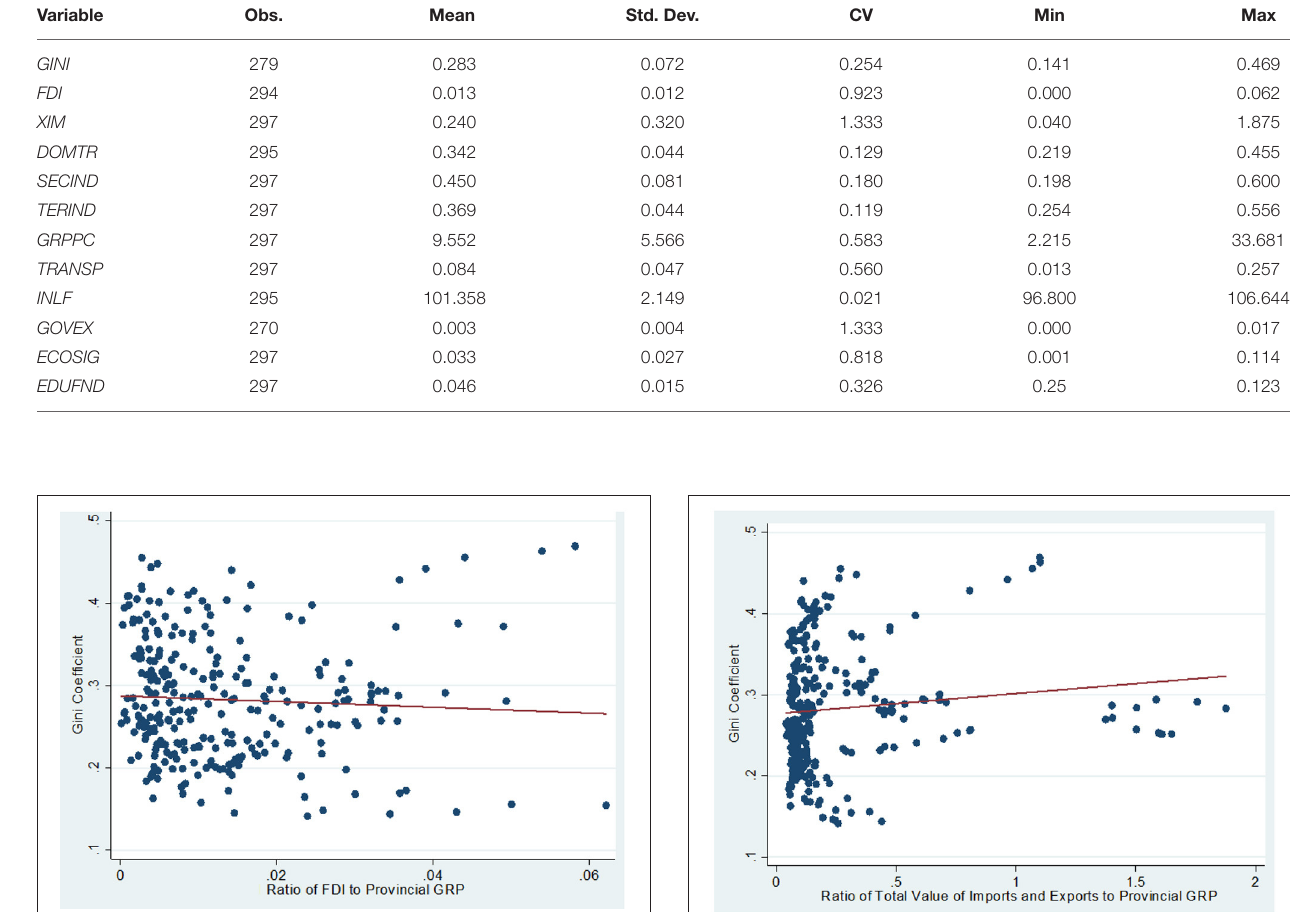
FIGURE 3 | Intra-provincial regional inequality (GINI variable) and the ratio of the total value of imports and exports to provincial GRP (EXIM